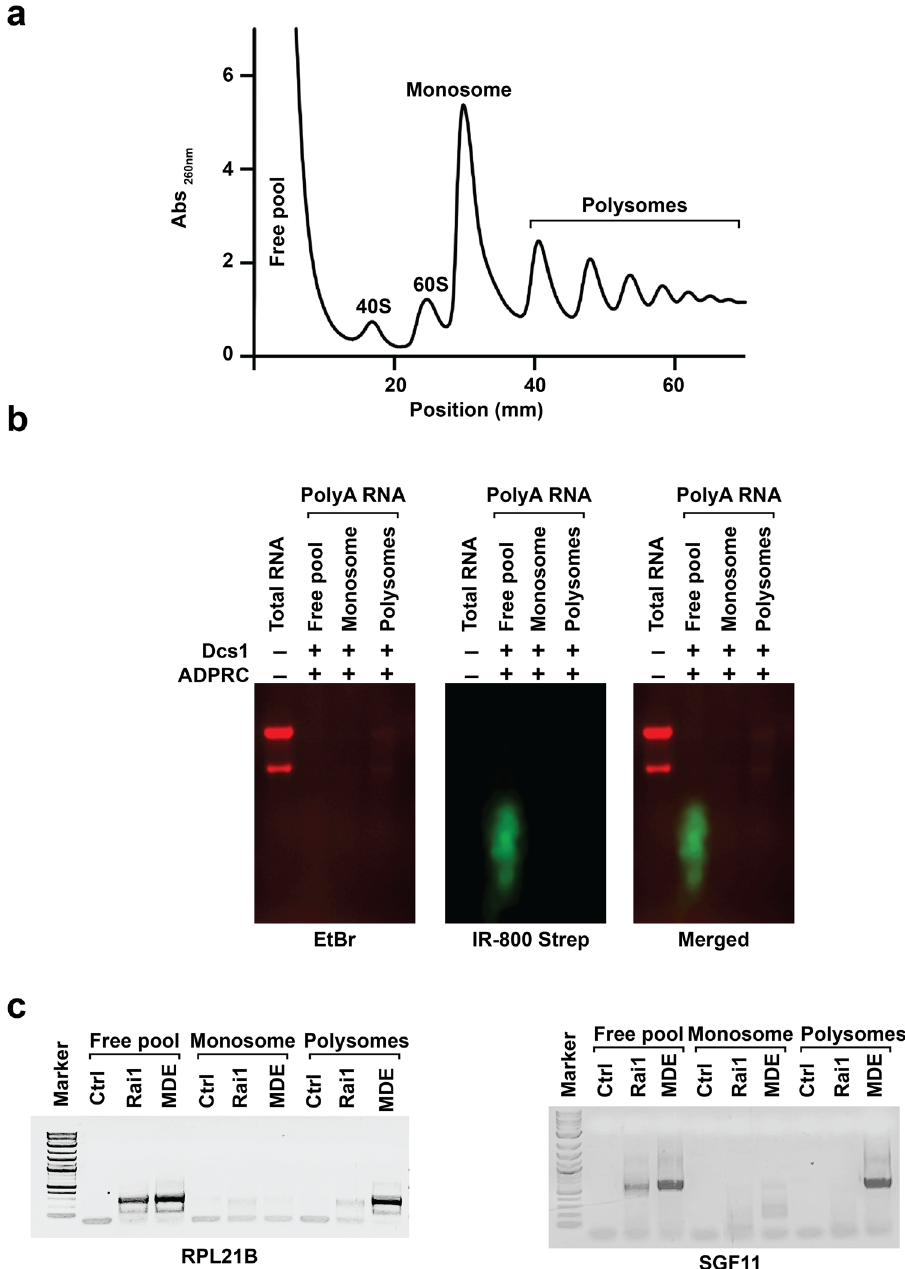
Fig. 5 Nuclear-encoded NAD-capped RNAs are not translated. Polysome gradient pro fi le of WT cells. Sucrose-density gradient ultracentrifugation was used to fractionate the free pool, ribosomal subunits, monosome, and polysomes. a Optical density pro fi les (Abs 260nm ) of polysome gradient are shown. PolyA + RNA was isolated from the free pool, monosome, and merged polysome fractions and analyzed by NADcapPro. b NAD-RNAs were visualized using IR dye. Noticeably, NAD-capped RNAs were exclusively detected in the free pool representative of the fraction of polyA + RNAs not engaged in translation. c PolyA + RNA from the polysome gradients was subjected to circNC analysis and transcript-speci fi c PCR of the RPL21B and SGF11 circularised RNAs are shown. The Rai1 and MDE treated lanes represent NAD- and m 7 G-capped RNAs respectively. The Ctrl is RNA that was not treated with either Rai1 or MDE enzymes. PCR products were resolved on a 1.5% TAE-agarose